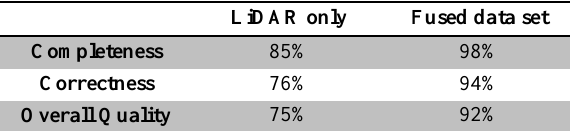
Table 1. Accuracy analysis of the results.